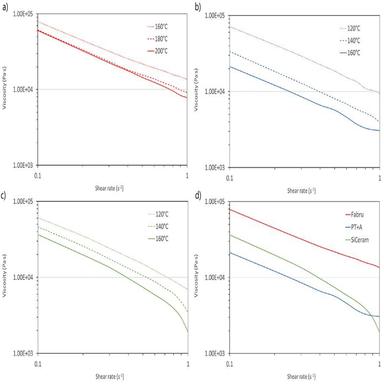
Rheological analysis for the three YSZ filaments at different temperatures, a) Fabru, b) SiCeram, c) PT+A, and d) comparison of all three filament materials at 160 ◦C.